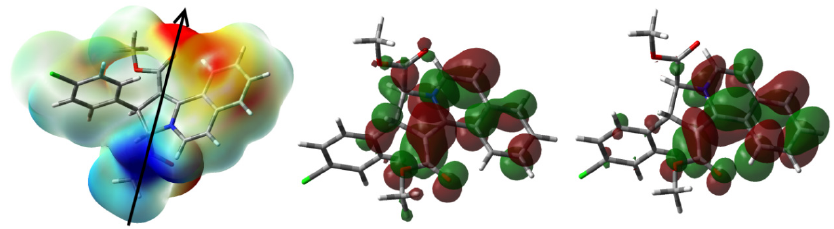
Figure 7. The MEP, HOMO and LUMO of 3 .